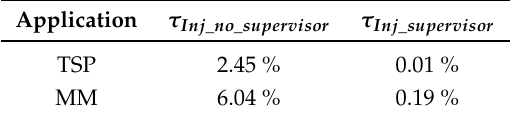
Table 6. Error-rates for 4MR-8Par applications implemented on the